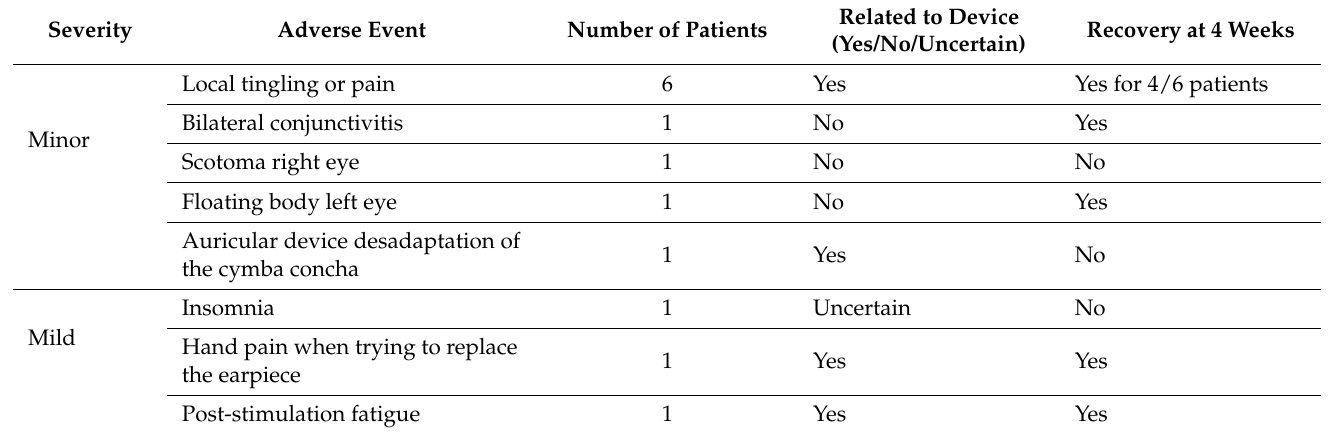
Table 2. Reported adverse events of 4 weeks of the taVNS in EHOA patients.